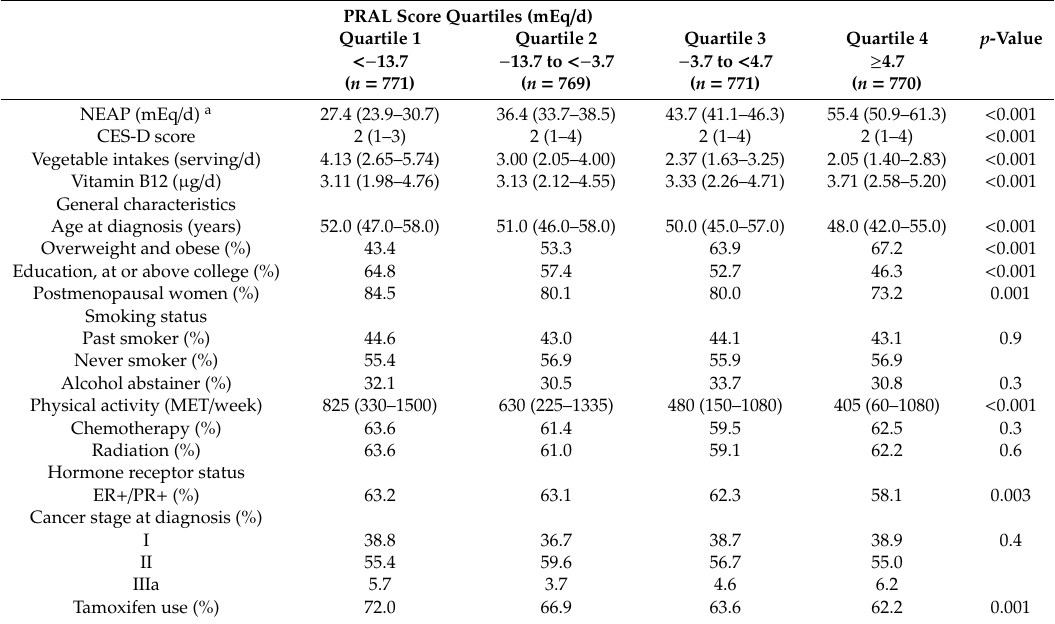
Table 2. Baseline characteristics according to quartiles of the PRAL score in the WHEL study ( n =